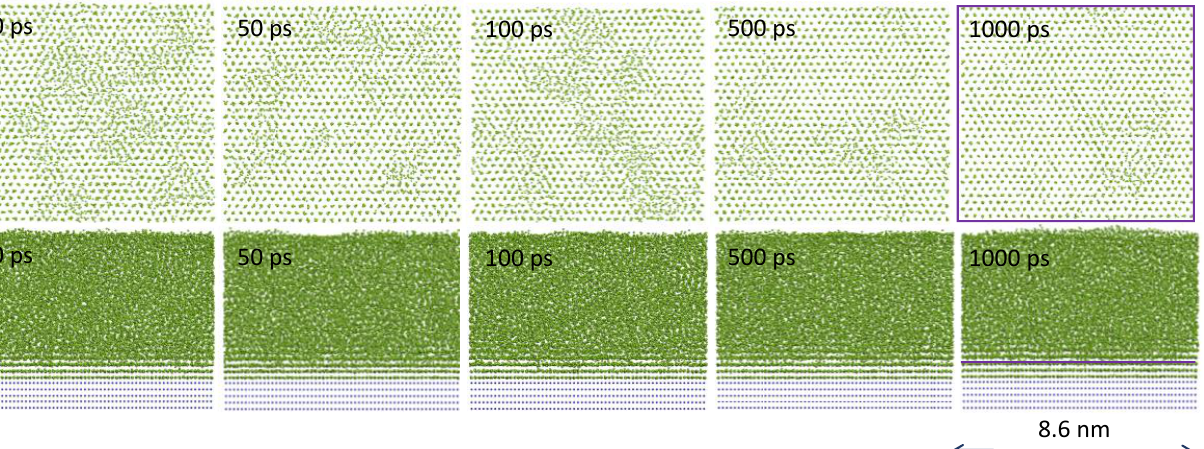
Figure 5. Demonstration of heterogeneous nucleation process in the case of r N ≤ r n . Time-averaged atomic positions of a simulation system with 2% lattice misfit showing the evolution of atomic arrangement in the simulation system (front view) and in L3 (the top view) during the heterogeneous nucleation process. Nucleation is completed at t = 1000 ps to provide a 2D nucleus (L3), which is a crystal plane of the solid (marked in purple). For this system, nucleation occurs at Δ T n = 40 K (2 r n = 14.1 nm) on a substrate of 2 r N = 8.6 nm ( Δ T gi = 66 K).